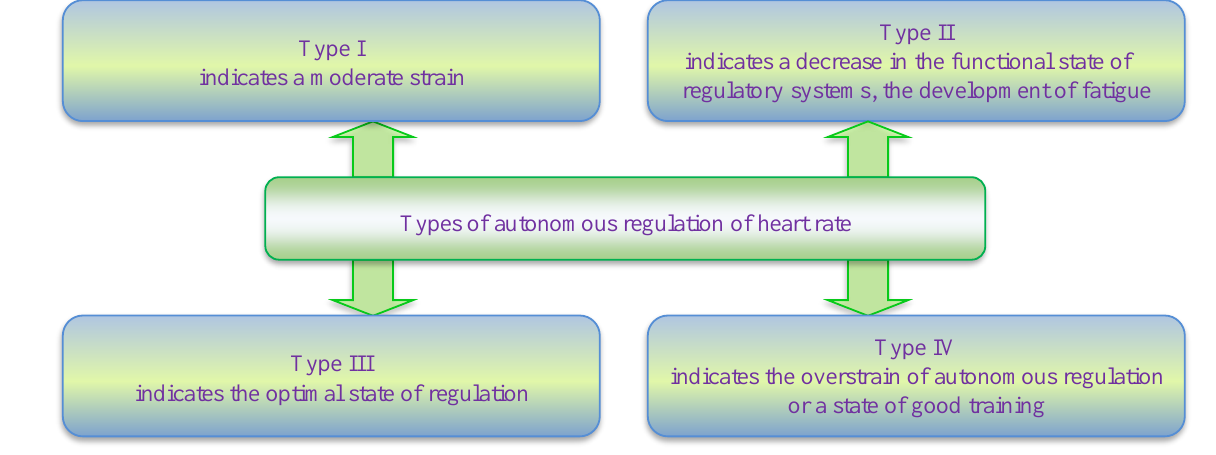
Figure 1. Types of autonomous regulation of heart